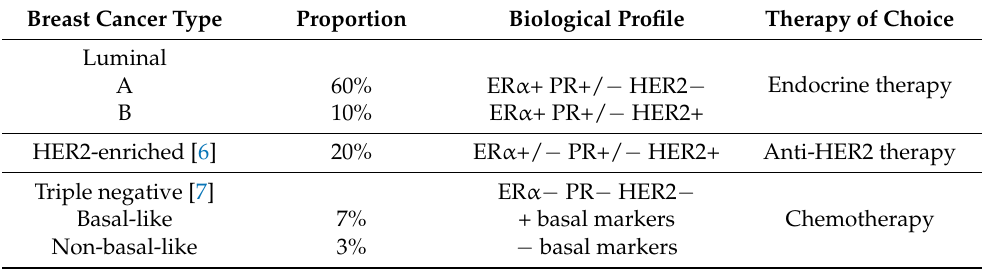
Endocrine therapyA 60% ER α + PR+/ − HER2 −